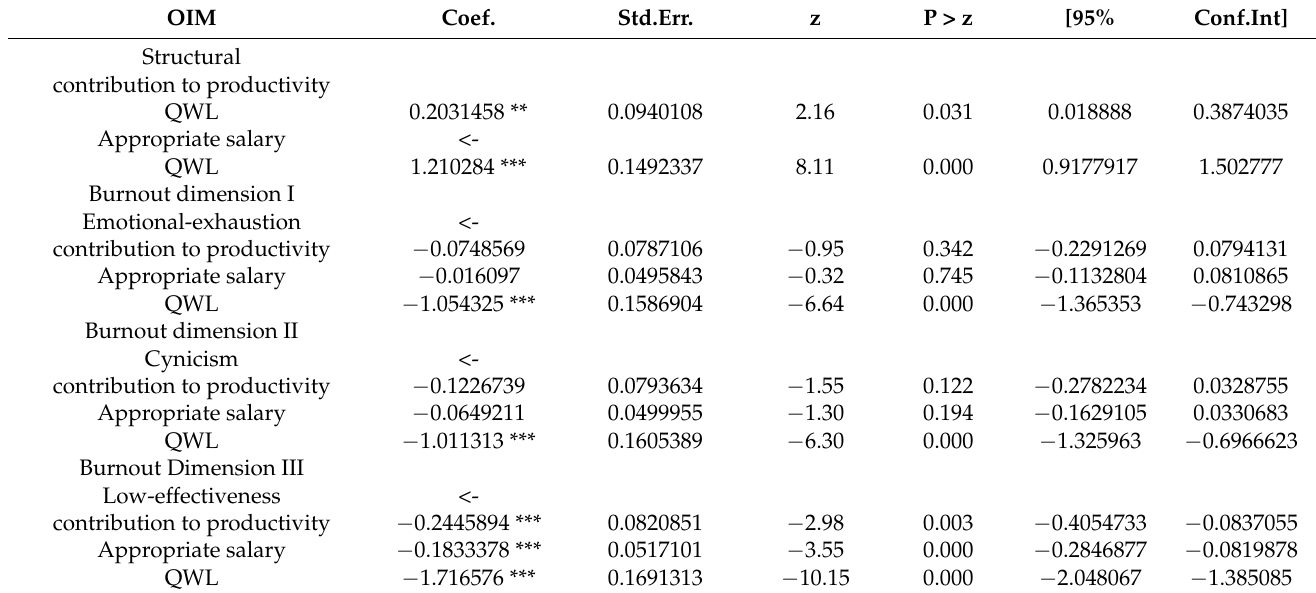
Table 8. Model 2: Total